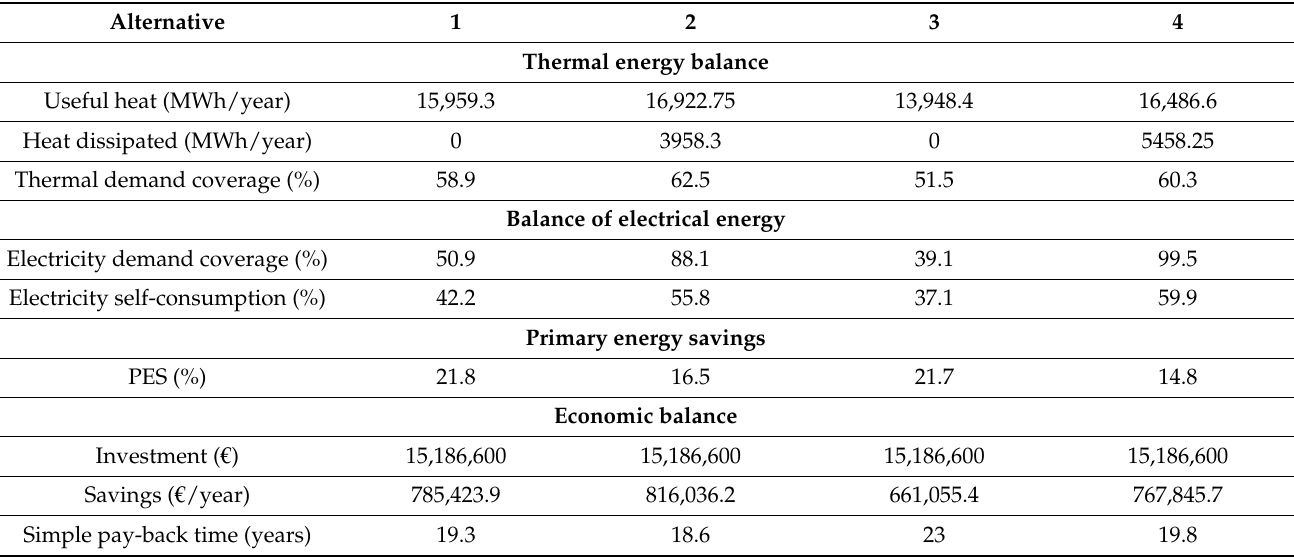
Table 9. Comparison of alternatives of the CHP system with 4 MW thermal